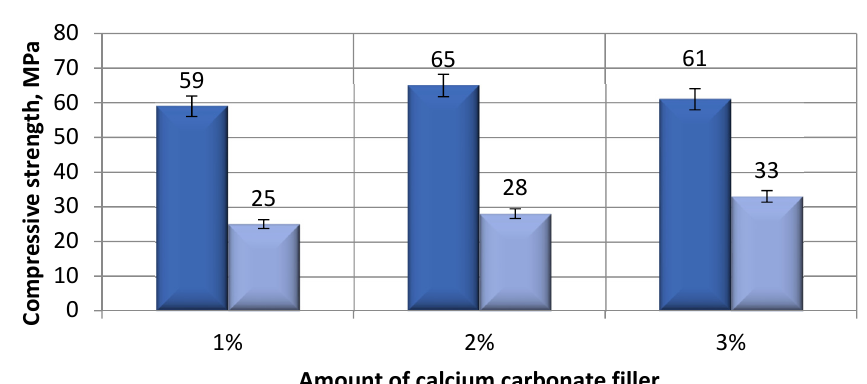
Figure 12. Comparison of the compressive strength between the E5 / PAC / 100:80 and E57 / PAC / 100:80